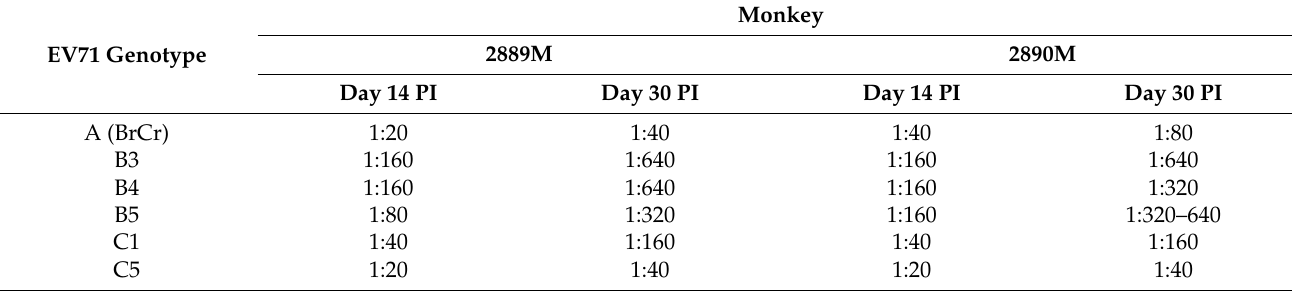
Table 4. The titre (unit in term of fold of dilution) of neutralizing antibodies against a number of subgenogroups of EV-A71 (A, B3, B4, B5, C1 and C5) present in the sera of two monkeys given intravenous EV71:TLL β P20. Titres were determined by microneutralization